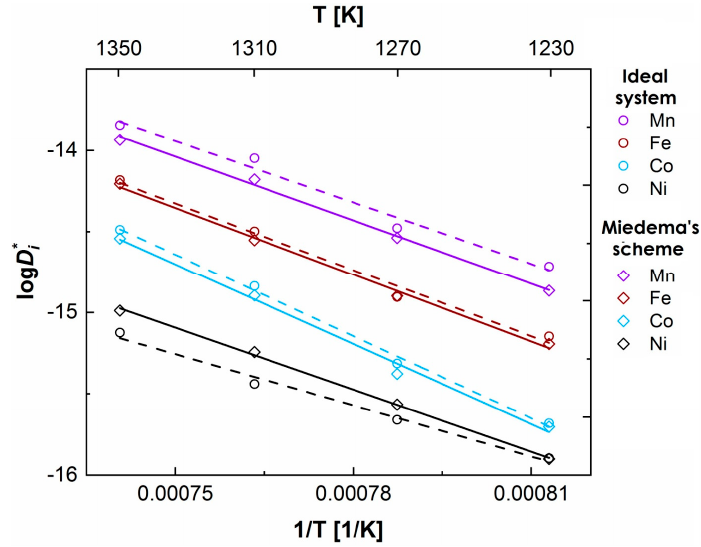
Figure 26. Comparison of the Arrhenius plots for the tracer diffusivities obtained for the Co-Fe-Mn-Ni using ideal system assumptions and values of interaction parameters provided by Miedema's scheme [45]. Reprinted from Journal of Alloys and Compounds 783 (2019), Demystifying the sluggish diffusion effect in high entropy alloys, 193–207, Copyright 2019, with permission from Elsevier.